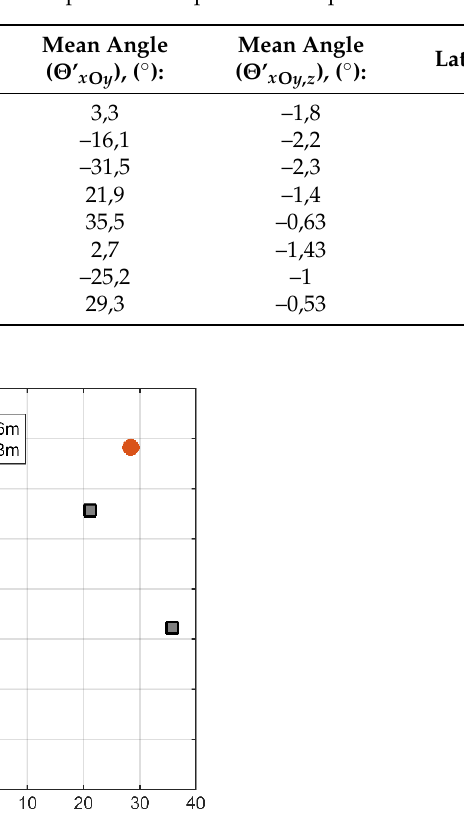
Table 4. Absolute lateral error values dependent on special source position.